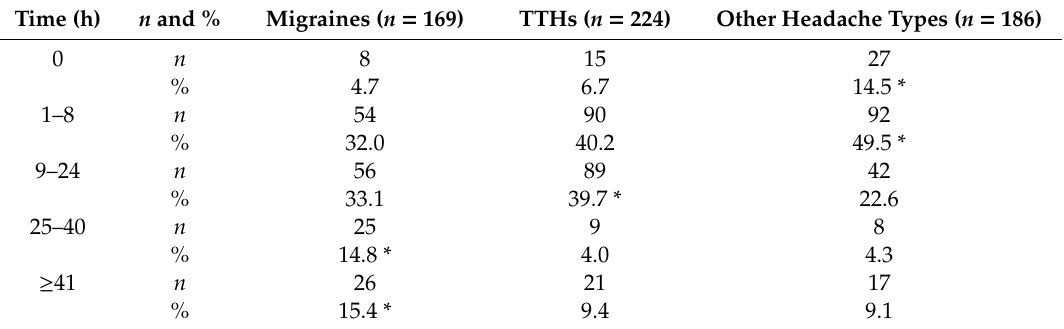
Table 2. Number ( n ) and percentage (%) of subjects working in spite of a headache in a